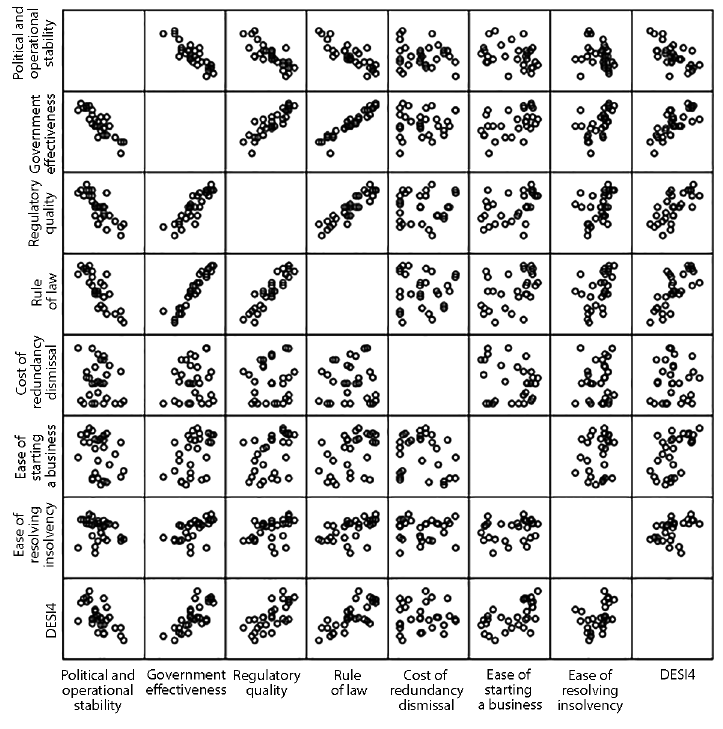
Figure A2. The bivariate links between DESI4 and Institutions sub-pillars of GII and the bivariate links between the Institutions